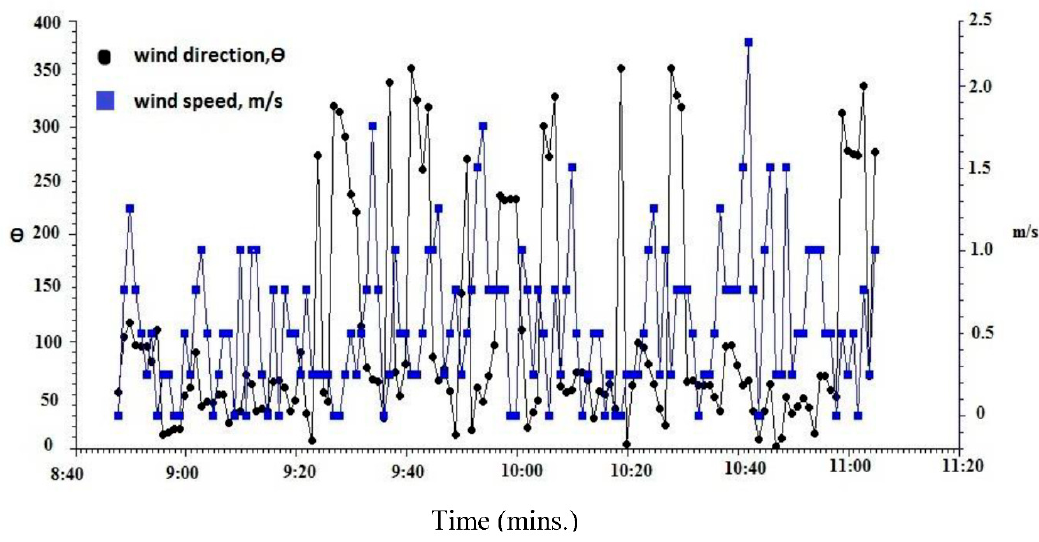
Figure 3. Wind characteristics during the field experiment.